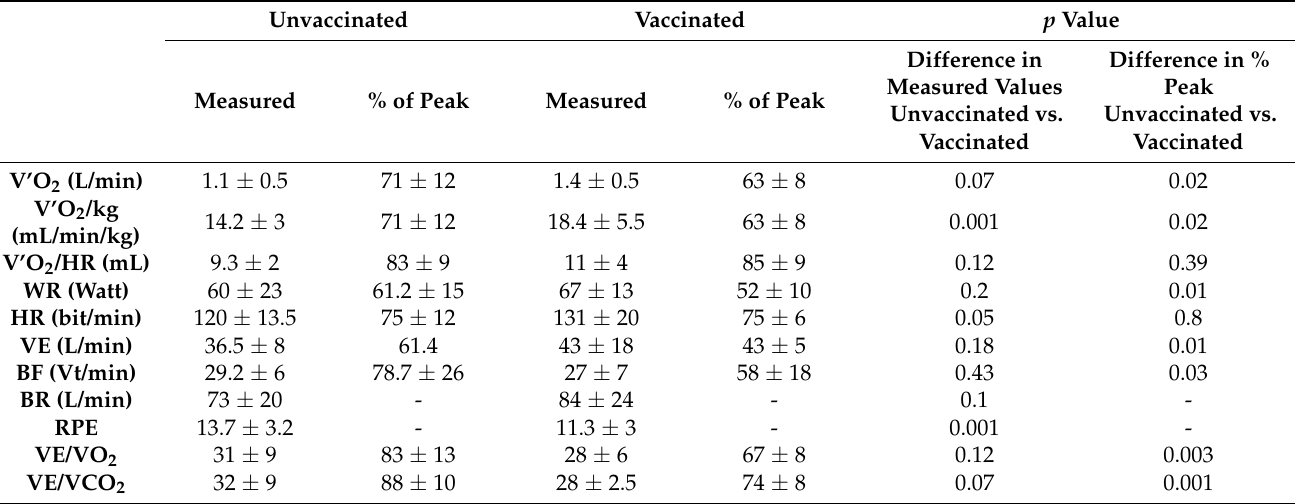
Figure 2. Percentage of predicted value peak V’O 2 ( A ) and ventilation (VE) ( B ). The dashed line represents 80% of the predicted value (* p < 0.05). Table 3 summarizes the cardiopulmonary at the anaerobic threshold (AT). Table 3. Measurements at anaerobic threshold